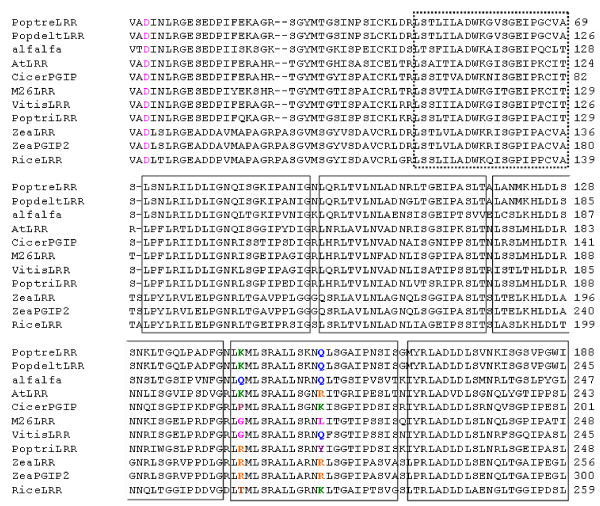
Alignment of monocot and dicot leucine-rich repeats (LRR) homologues of the alleleMxdRLP1. Only the regions where amino acid replacements were detected in the apple LRRs are shown in the alignment. Numbers of amino acids from the presumed translation start methionine are listed to the right of the sequence. Amino acid substitutions at indicated loci are shown color-coded to highlight conservation or variation. Rectangular boxes indicate the positions of consensus LRRs. A dashed rectangle indicates deviation from the LRR consensus sequence. AtLRR: Arabidopsis thaliana (GenBank:NP188718, locus tag AT5G20820) ribonuclease inhibitor-like (RIL) LRR subfamily; PoptreLRR: Populus tremula (GenBank:ACE97248) RIL LRR subfamily; PopdeltLRR: P. deltoides (GenBank:ABS18952) RIL LRR subfamily; PoptriLRR: P. trichocarpa (GenBank:ABK92966) LRR; Alfalfa: Medicago truncatula (GenBank:ACJ85058); VitisLRR: Vitis vinifera (GenBank:CAO21943) RIL LRR subfamily; CicerPGIP: Cicer arietinum (GenBank:CAD56505) polygalacturonase inhibitor-like protein (PILP); ZeaLRR: Zea mays (GenBank:ACF88180) RIL LRR subfamily; ZeaPGIP2: Z. mays (GenBank:NP001150670) PILP; RiceLRR: Oryza sativa (GenBank:NP001062185); MxdRLP1-1: allele (GenBank:XX000002) found in the fire blight susceptible Malus x domestica cultivars ‘Malling 26’, ‘Malling 27’ and fire blight resistant ‘Robusta 5’.